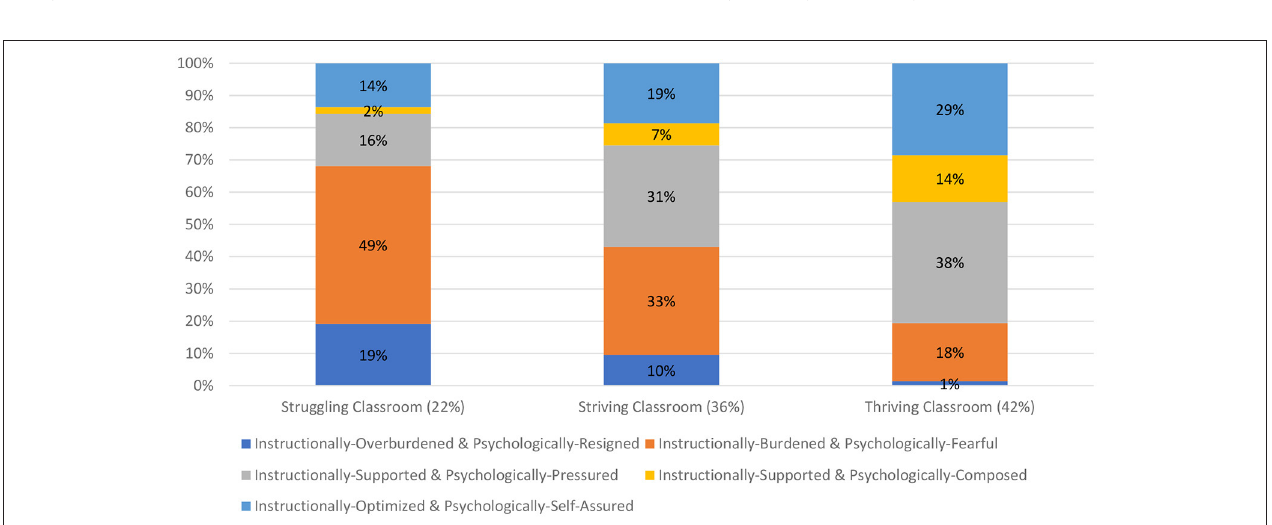
(lowest disengagement; M = − 0.427). For classroom-average achievement, with one exception (Striving = Thriving), each classroom profile was significantly different from the